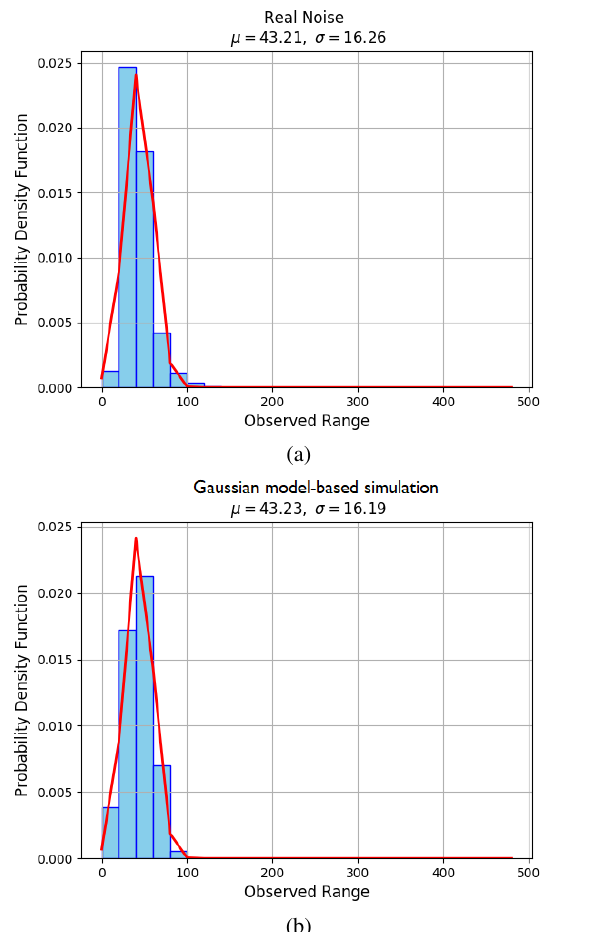
Figure 8: Comparison of the distribution of a) real noise from Figure 7-a) and b) GM-Simulation synthetic noise from Figure